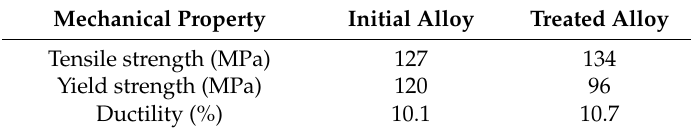
Figure 5. Stress-strain curves for initial alloys and alloys treated by oxygen blowing. Table 3. Mechanical properties of initial alloys and alloys treated by oxygen blowing.